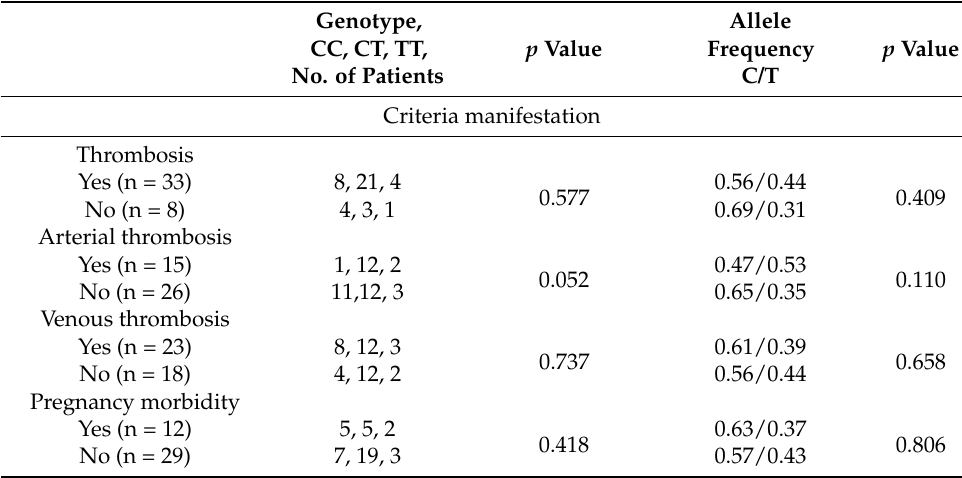
Table 4. MTHFR C677T genotype and clinical manifestations in APS